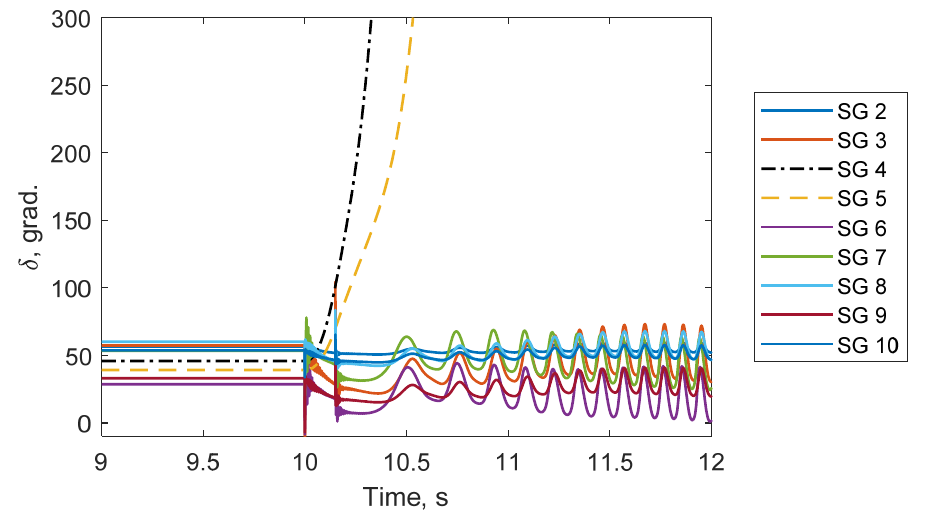
Figure 7. Load angle values of generators during the transient.